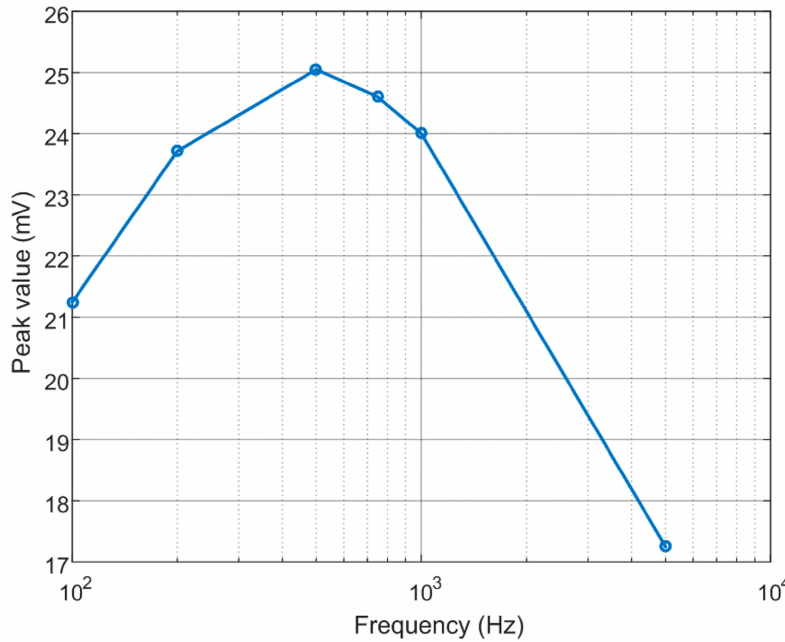
Figure 5. Variation in the simulated signal peak with the excitation